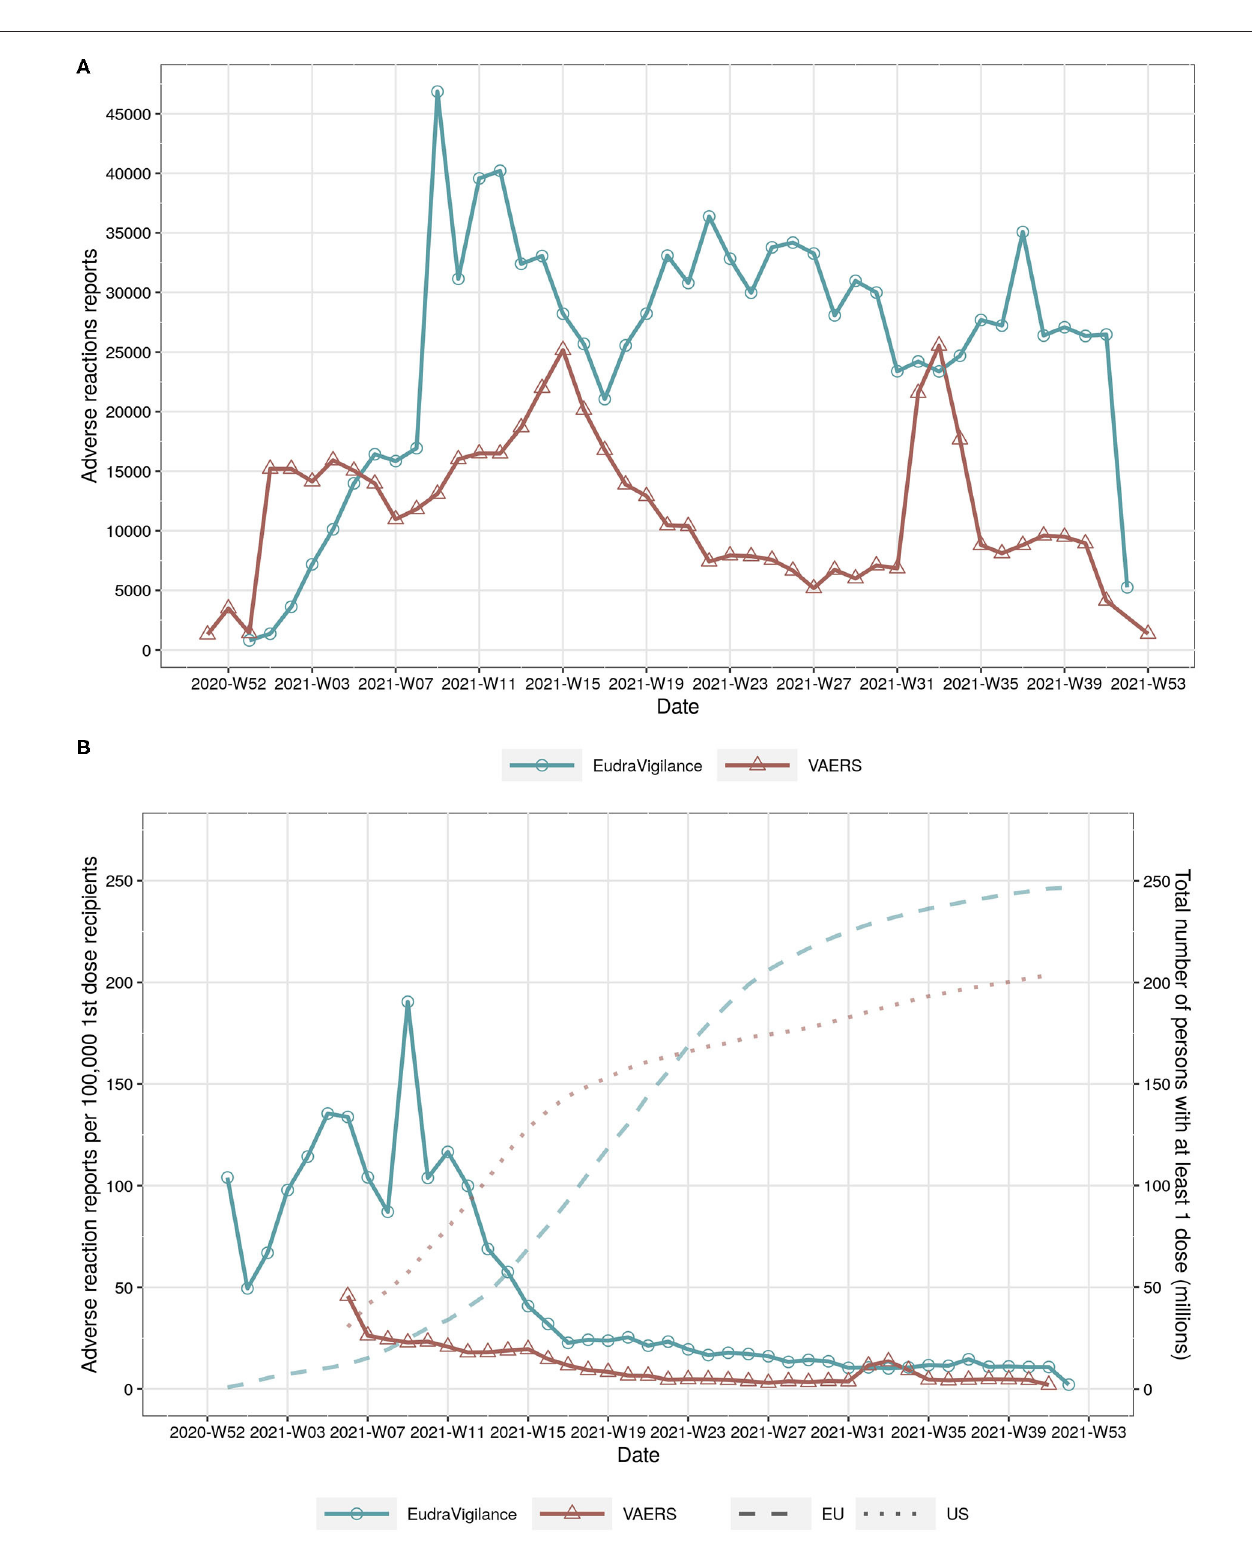
FIGURE 1 | (A) total number of adverse reactions reports in EudraVigilance and VAERS by year and week. (B) number of adverse reactions reports per 100,000 persons with at least 1 COVID-19 vaccine dose (continuous line, left y-axis) and total number of persons with at least 1 dose in the EU and US by year and week (dotted lines on background, right